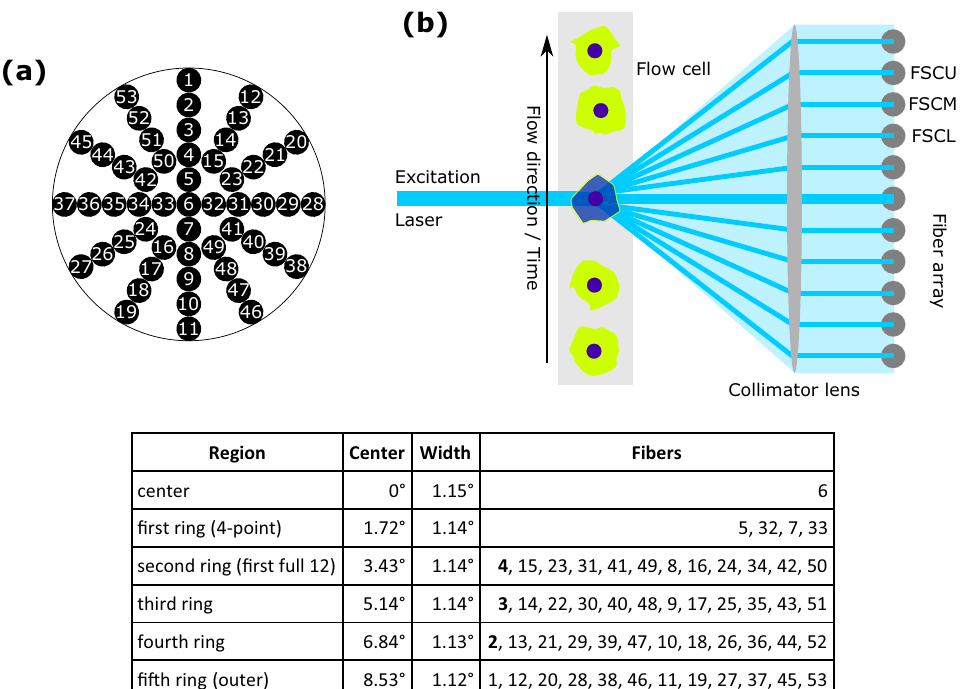
Fig. 6 Design of the FSC light detection system. a Front view of fi ber array. It consists of 53 individual fi bers. Each fi ber opening has a diameter of 1mm and the distance between the fi ber centers is 1.5mm. b Schematic side view of the optical arrangement for FSC light detection with the fi ber array providing angular resolution. For the sake of simplicity, not all optical elements are shown (lenses, aperture). The fi ber array is located to the right and this side view shows the vertical row (1 – 11) in panel ( a ). Exemplarily, three detectors are labeled (exact positions on the fi ber array and resulting detection angles can be seen in the Table).